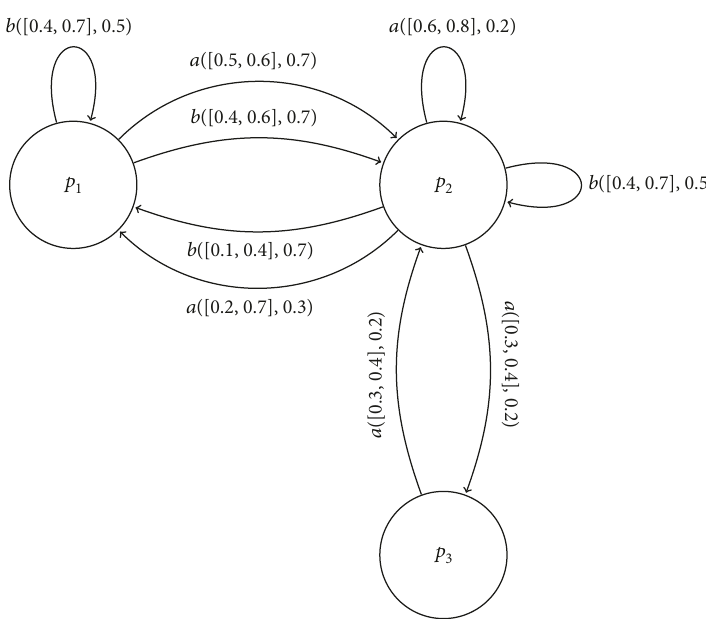
Figure 2: A commutative cubic fsm T = ⟨ P , 𝑋, 𝜑⟩